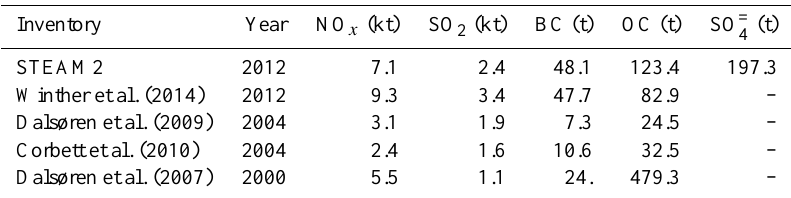
in different ship emission 4